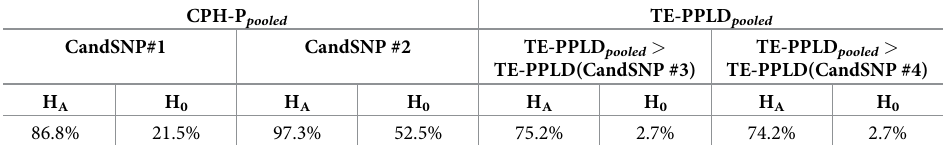
Table 9. Probability of successful replication based on “pooling” initial and follow-up data sets, when following up on SNPs selected for moderate or high association signals. CPH-P TE-PPLD pooled pooled CandSNP#1 CandSNP #2 TE-PPLD pooled > TE-PPLD pooled > TE-PPLD(CandSNP #3) TE-PPLD(CandSNP #4) H A H 0 H A H 0 H A H 0 H A H 0 86.8% 21.5% 97.3% 52.5% 75.2% 2.7% 74.2% 2.7% CPH-P pooled : Shown here are the proportion of pooled (N = 600) CPH-P exceeding the replication criterion of 5, when the initial data set (N = 400) is pooled with each of 1,000 replication data sets of size N = 200 each, generated under either H A (Model Epi 1 from Table 7) or H 0 (Model 1 from Table 1). CandSNP#1 selected based on CPH-P = 5.7 in the initial (N = 400) data set, CandSNP#2 selected based on CPH-P = 7.3. TE-PPLD pooled : Shown here are the proportion of pooled (N = 600) TE-PPLDs exceeding the initial TE-PPLD, when the initial data set is pooled with each of those same 1,000 replication data sets, generated under either H A (Model Epi 1) or H 0 (Model 1). CandSNP#3 TE-PPLD selected based on TE-PPLD = 0.53 in the initial data set, CandSNP#4 TE-PPLD selected based on TE-PPLD =